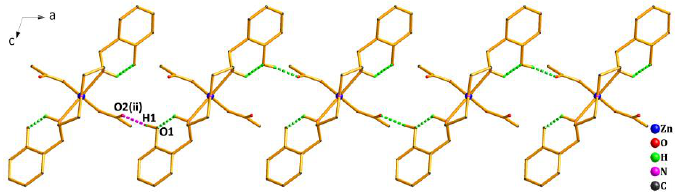
Figure 4. 1D hand-in-hand-like chain structure of Complex 2 via hydrogen bonds along the a axis. Symmetry code: (ii) 1/2 − x, −1/2 + y,1/2 − z. Symmetry code: (ii) 1/2 − x, −1/2 + y,1/2 − z. Symmetry code: (ii) 1 / 2 − x, − 1 / 2 + y,1 / 2 −